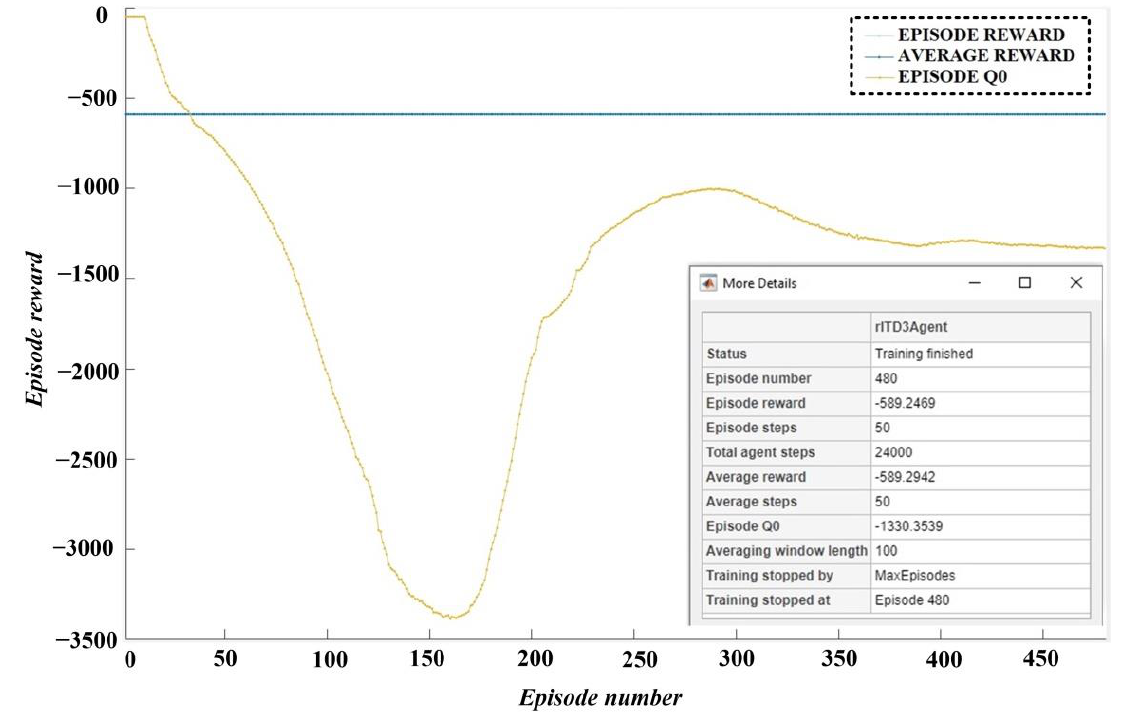
Figure 17. Reward evolution during the training stage of the RL-TD3 agent for the command-signal- correction control systems of the power electronic converter using the FO SMC controller for the voltage outer control loop and the FO synergetic controller for the current inner control loop.